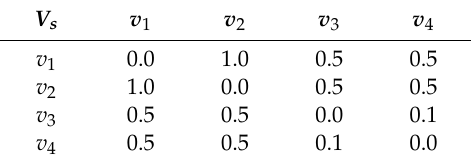
Table 8. Attribute value contradiction degree functions for s ∈ A ( c s ).